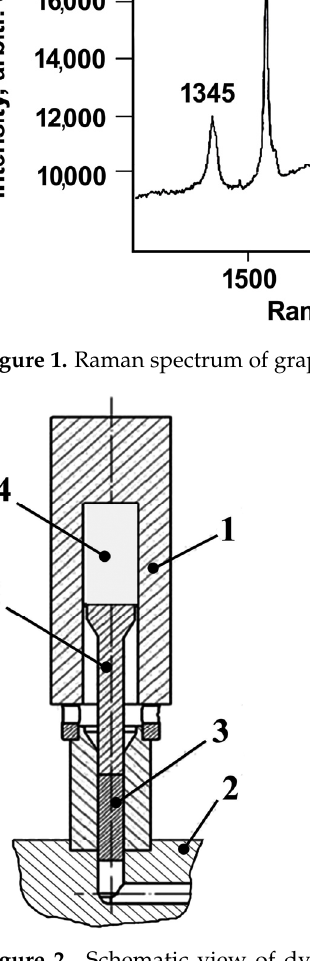
Figure 2. Schematic view of dynamic-channel angular pressing set up with plunger(1—barrel, 2—matrix, 3—sample, 4—powder charge, 5—plunger) [37].